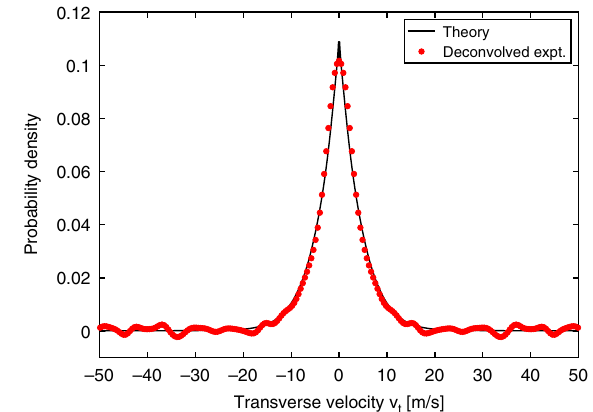
Fig. 3 Narrow angular spread of the cascaded collimator. Transverse velocity distribution derived from the measurement by deconvolution, along with the theoretical prediction from Monte – Carlo simulations